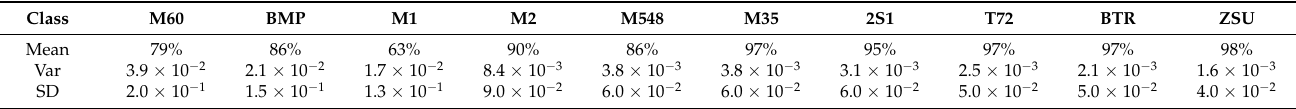
Table 10. RGB channel fusion intraclass variance (Var) and standard deviation (SD).